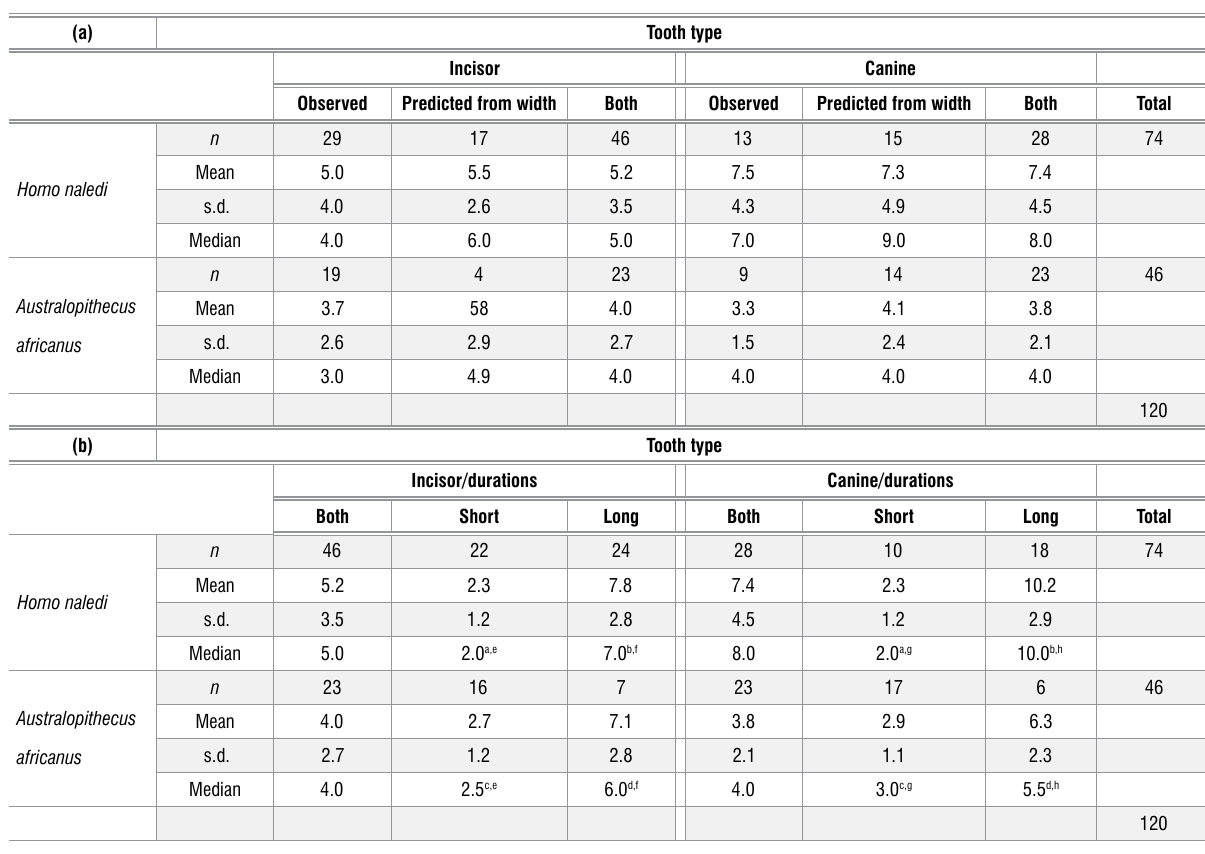
(a) Linear enamel hypoplasia (LEH) widths in terms of number of perikymata in occlusal wall: combining both those observed and those predicted from occlusal wall width. (b) Comparison of perikymata counts in occlusal wall of LEH defects (observed plus predicted) between tooth type and taxa (short and long modes